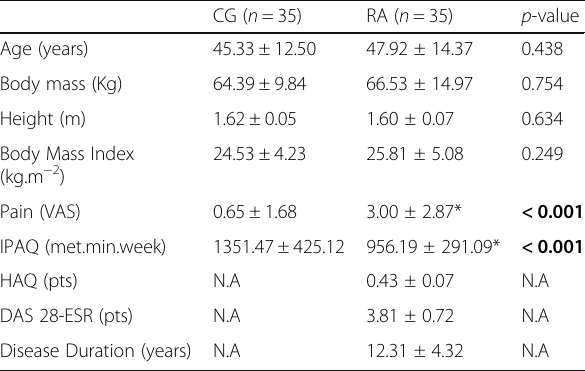
Table 1 Subjects ’ characteristics